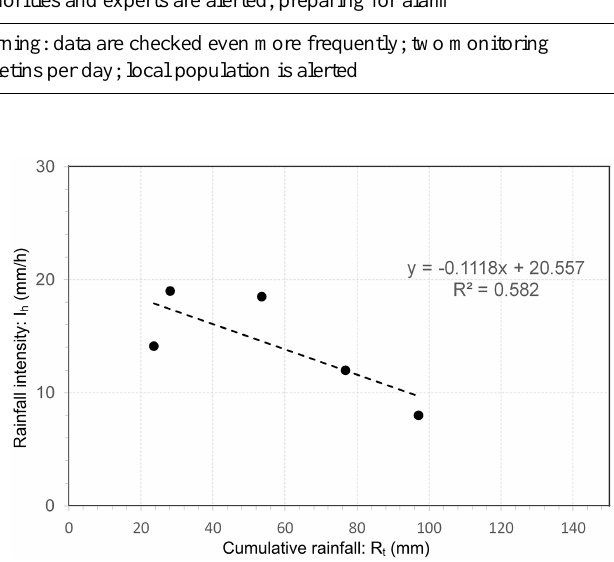
Figure 5. Improved method to ensure the gradient of the lower en-